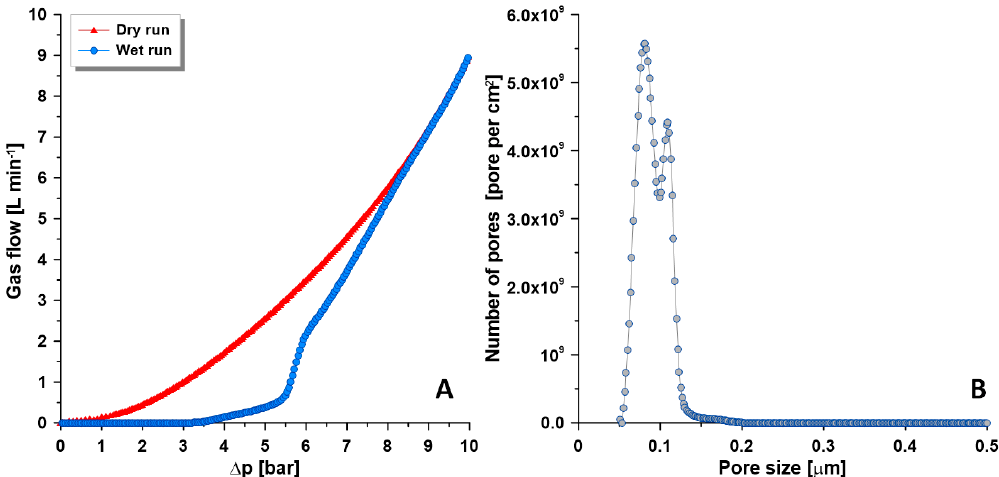
Figure 5. Porosity of PVA porous support. ( A ) gas fluxes in wet and dry runs; ( B ) pore size distribution.